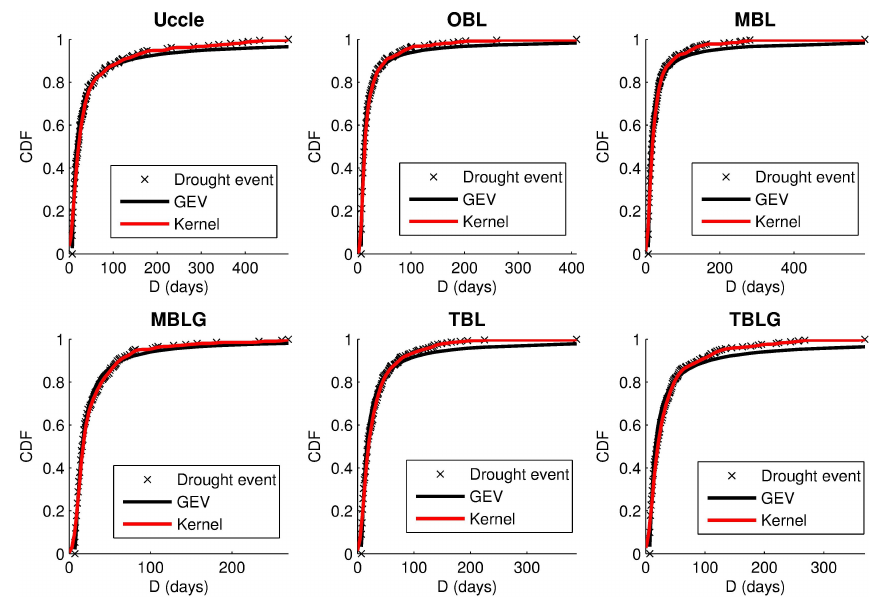
Fig. 5. GEV and Kernel cumulative distribution functions of drought duration D .